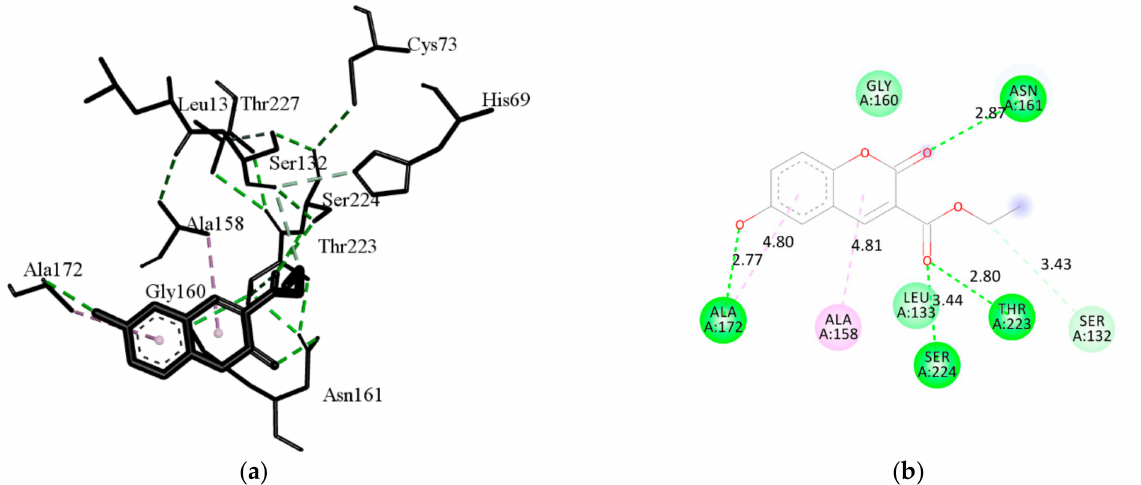
Figure 5. The main interactions of compound 6 with residues in the binding site of proteinase K: ( a ) 3D representation of the binding site; ( b ) 2D representation of main interactions with interatomic distances (Å). (green = conventional hydrogen bond; light green = van der Waals; very light green carbon-hydrogen bond; purple = π –alkyl